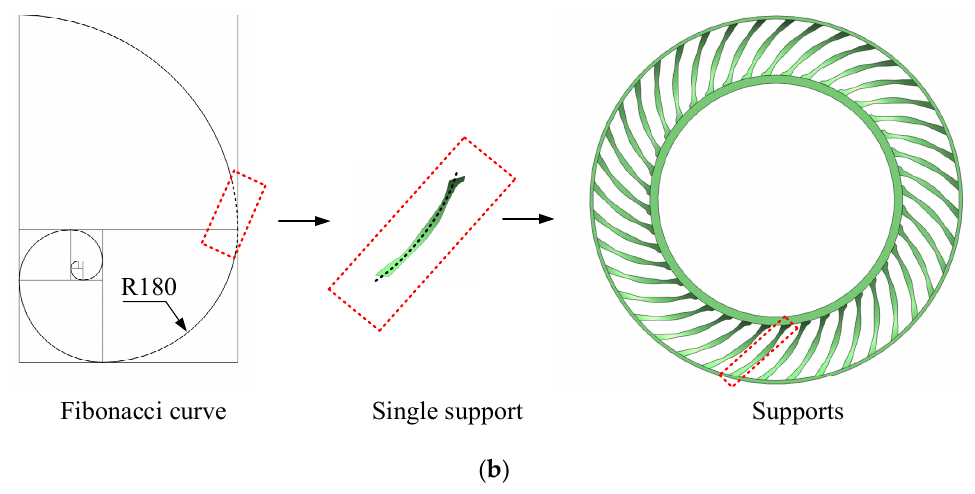
Figure 2. Geometric dimensions of NPT: ( a ) Overall dimensions; ( b ) Support dimensions.